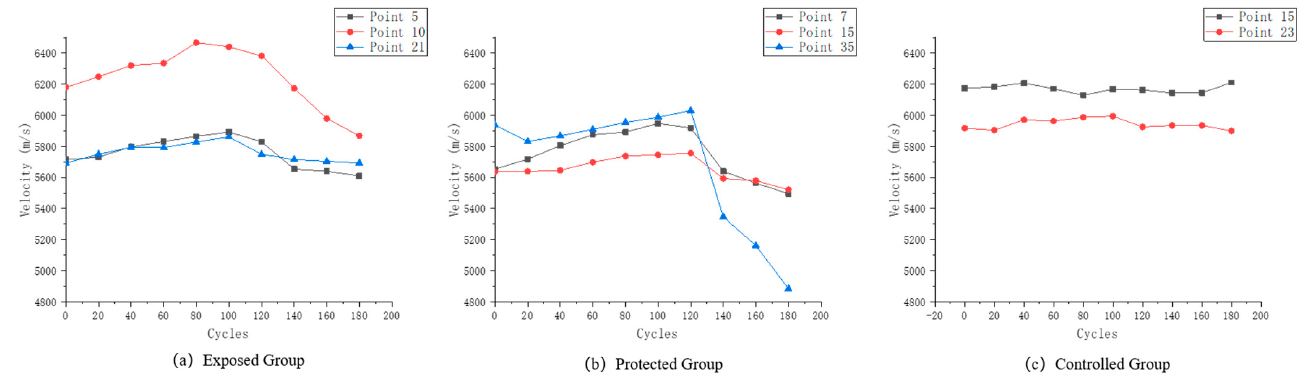
Figure 6. ( a ) Wave velocity variation of the characteristic measurement points of the exposed group; ( b ) Wave velocity variation of the characteristic measurement points of the protected group; ( c ) Wave velocity variation of the characteristic measurement points of the controlled group.